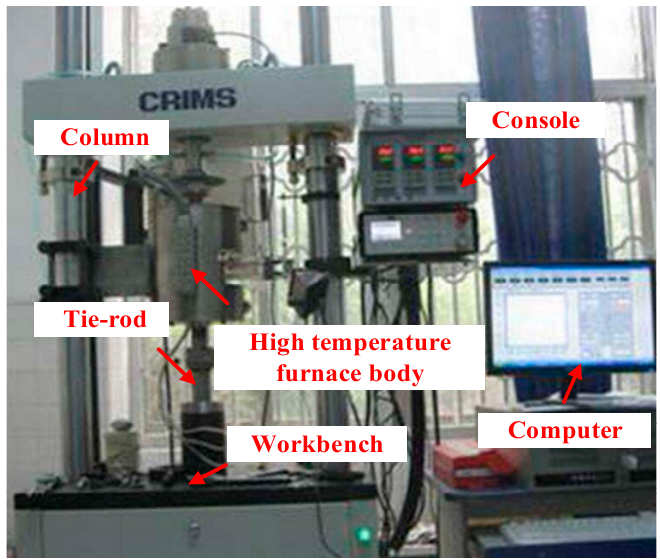
Figure 6. The high-temperature stress relaxation machine.